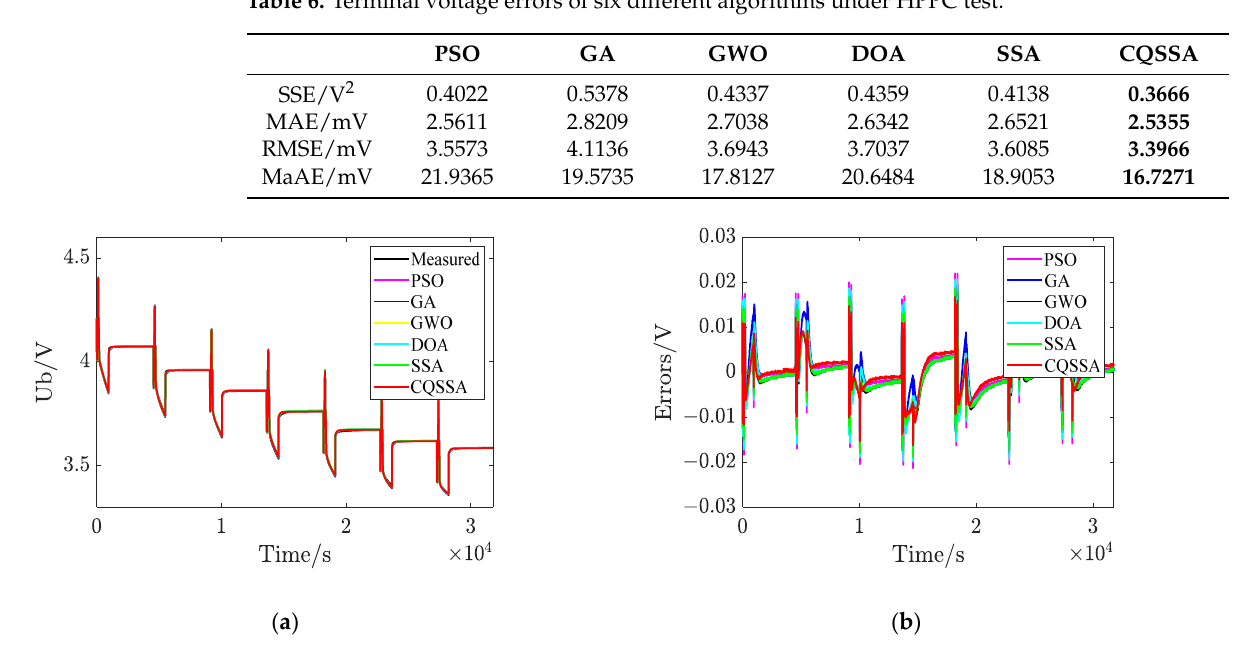
Figure 5. The comparison of estimated and measured voltages under HPPC test. ( a ) The comparison of measured and estimated terminal voltages. ( b ) The comparison of terminal voltage errors of six algorithms.